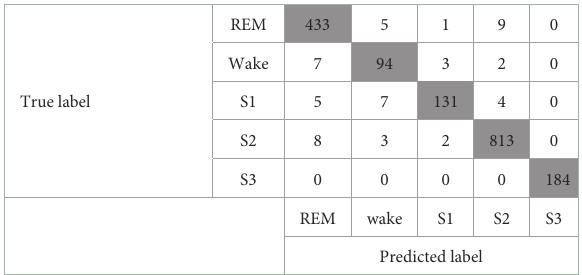
TABLE 7 Confusion matrix of one model that includes only the HRV-derived